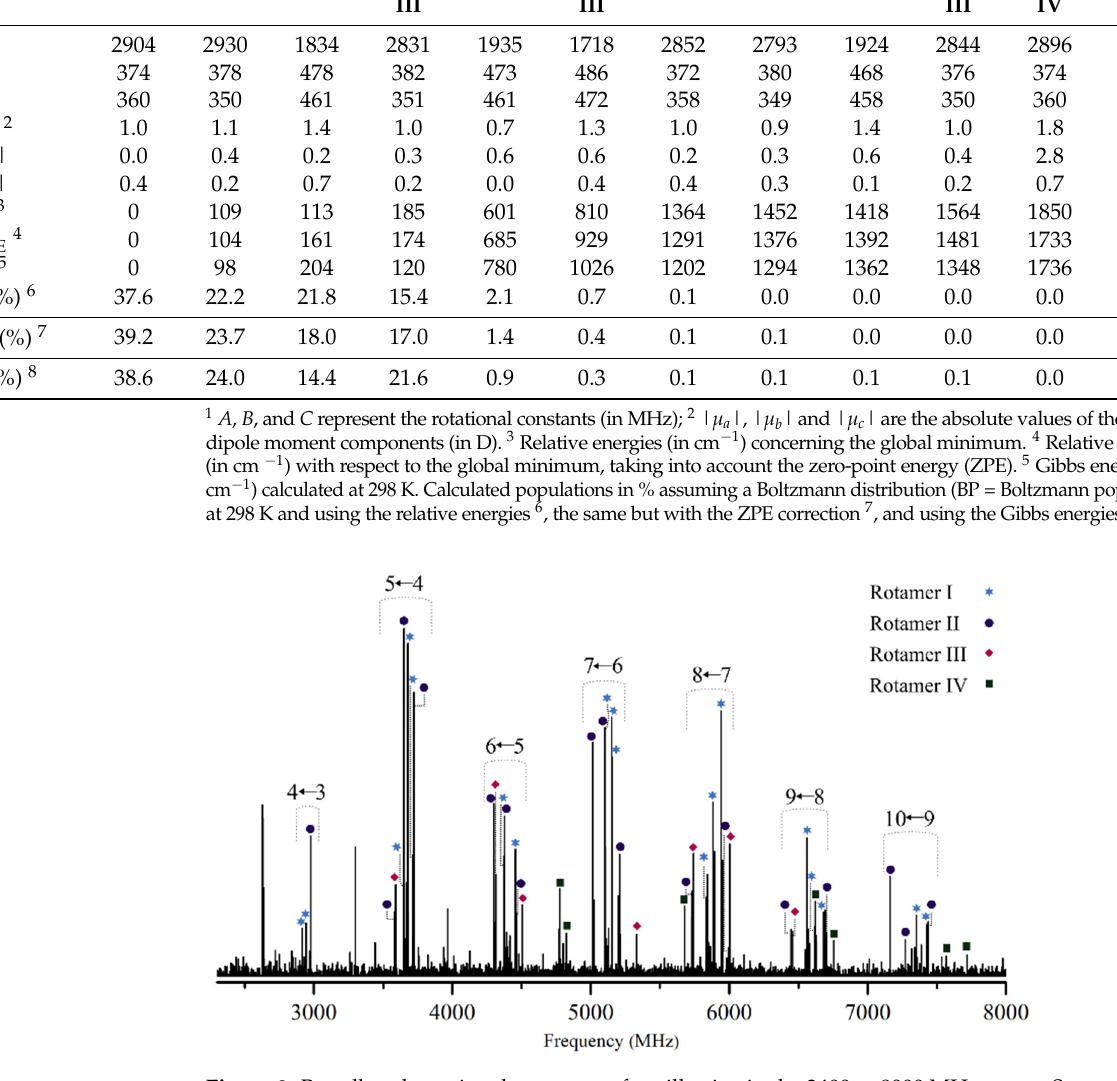
Figure 2. Broadband rotational spectrum of perillartine in the 2400 to 8000 MHz range. Some selected a -type transitions are highlighted for all assigned species. Table 2. Experimental spectroscopic parameters for the detected conformers of